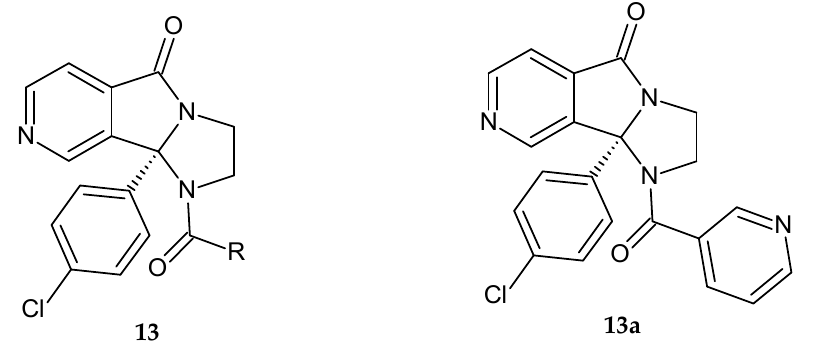
Figure 9. Imidazo[1’,2’:1,2]pyrrolo[3,4- c ]pyridin-5-one derivatives 13 with anti-RSV activity and the candidate for preclinical studies 13a .